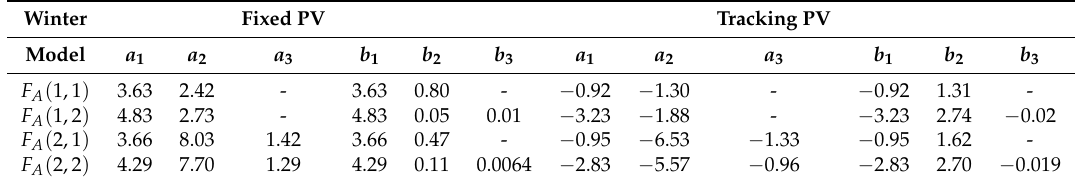
Table 3. Optimal coefficient values for model A both fixed and tracking PV system in Winter. Winter